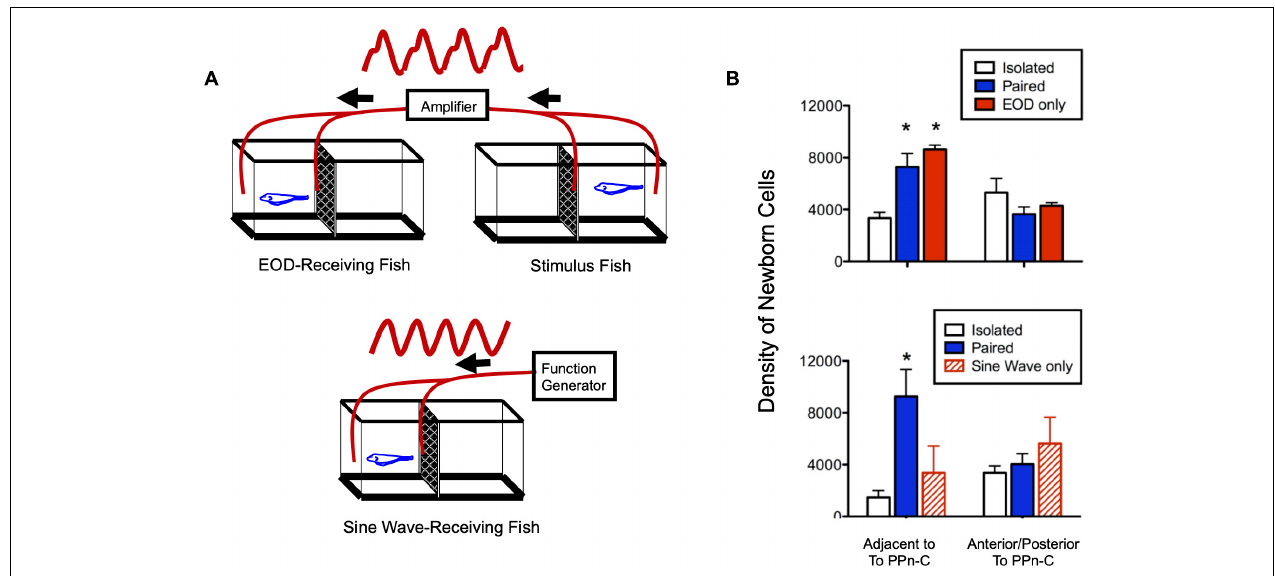
FIGURE 4 | Social electric signals stimulate neurogenesis in the electrocommunication circuitry. (A) Experimental set up in which fish received a real, one-way social electric signal from a conspecific (top) or an artificial sine-wave stimulus (bottom). (B) Fish exposed to direct paired social interaction or EOD stimulus alone have equivalently higher levels of neurogenesis compared to isolated fish in a neurogenic zone adjacent to the brain region controlling chirping (prepacemaker nucleus, PPn-C), but not in a neighboring control region (top). Fish receiving an artificial sine-wave stimulus show levels of neurogenesis equivalent to isolated fish (bottom). Asterisks indicate significantly different than isolated group. Adapted and modified from Dunlap et al.